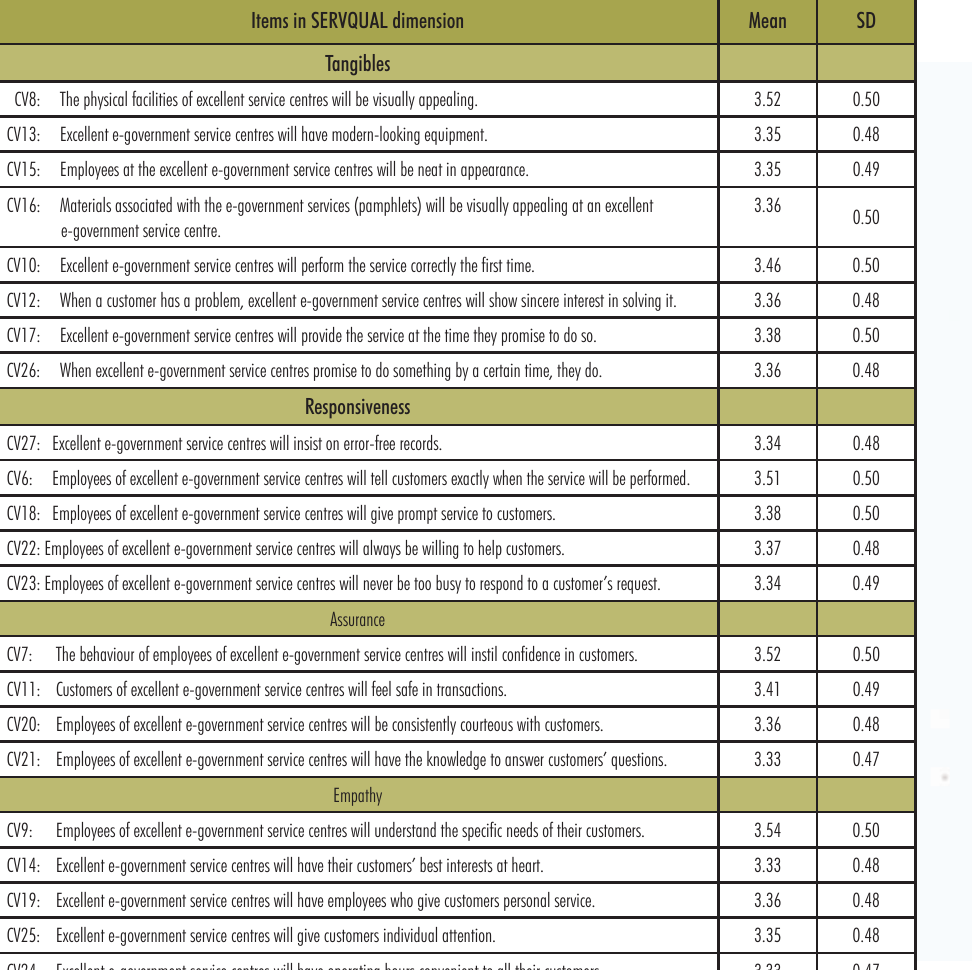
EXPECTATIONS SCALE ITEM MEAN AND STANDARD DEVIATION (N = 168) Items in SERVQUAL dimension Mean SD